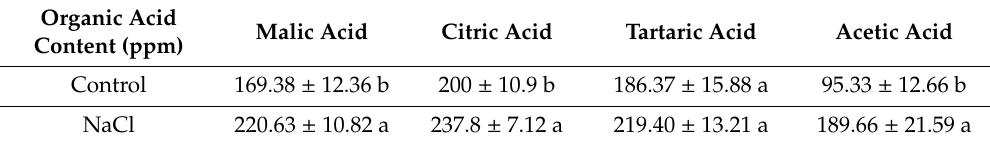
Table 2. Organic acid content of P. koreensis MU2 pure culture under normal and salt-stressed conditions. Organic Acid Content (ppm)